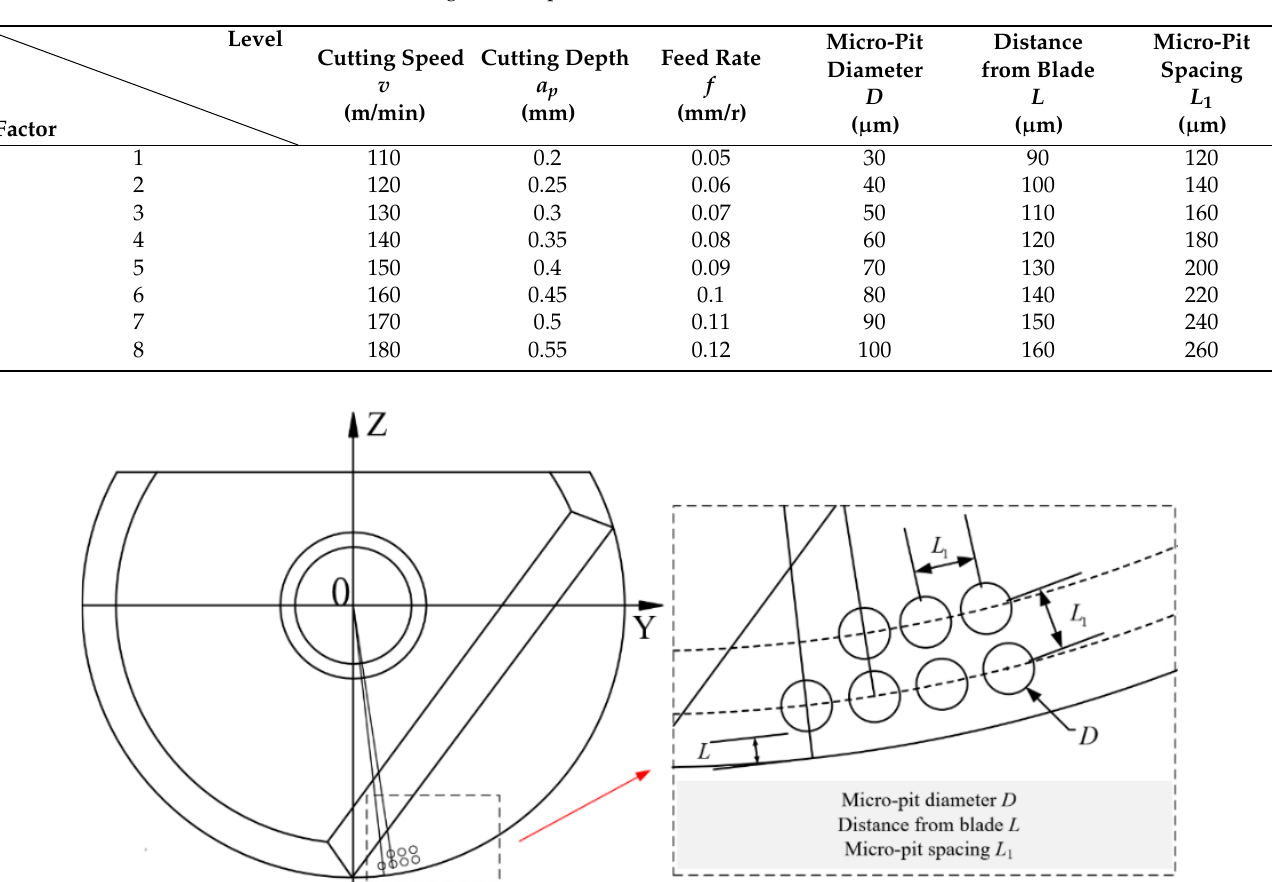
Table 1. Orthogonal test parameters.